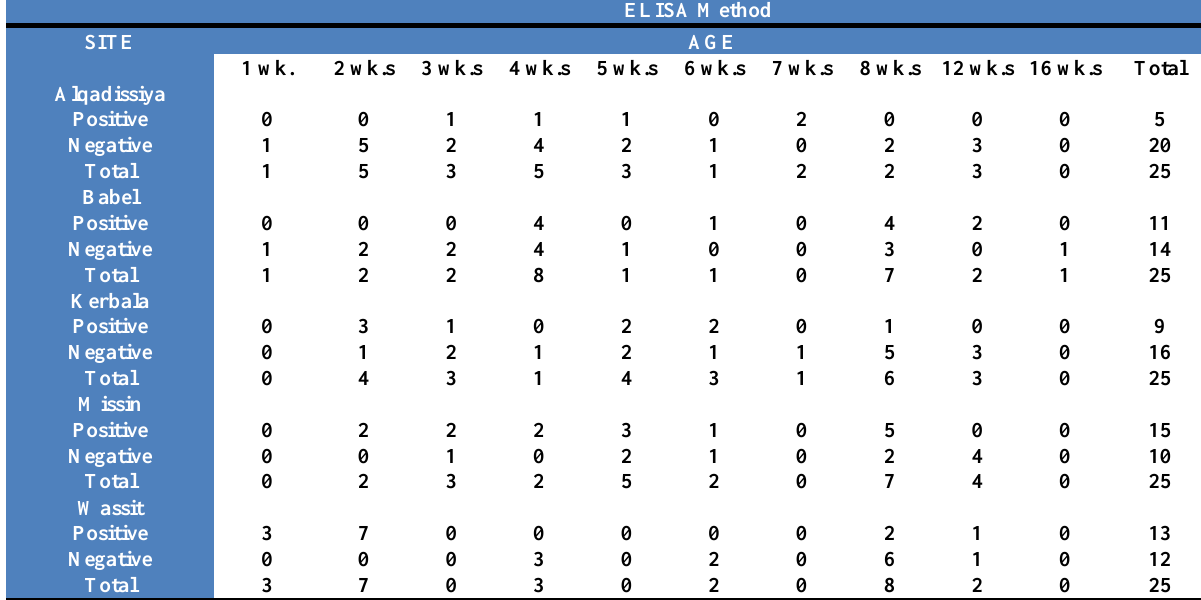
Table, 4: The results obtained by using ELISA method for Rotavirus in 125 fecal samples according to age of tested